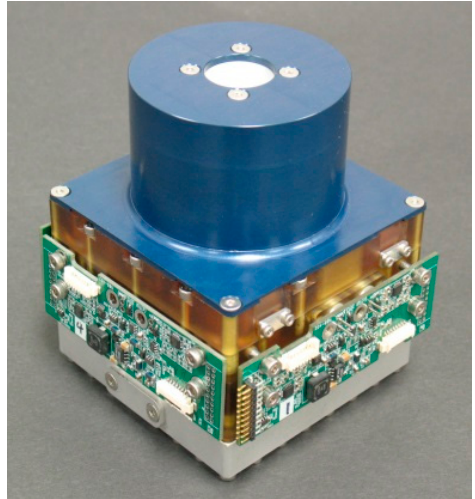
Figure 15. HYDROS [35].